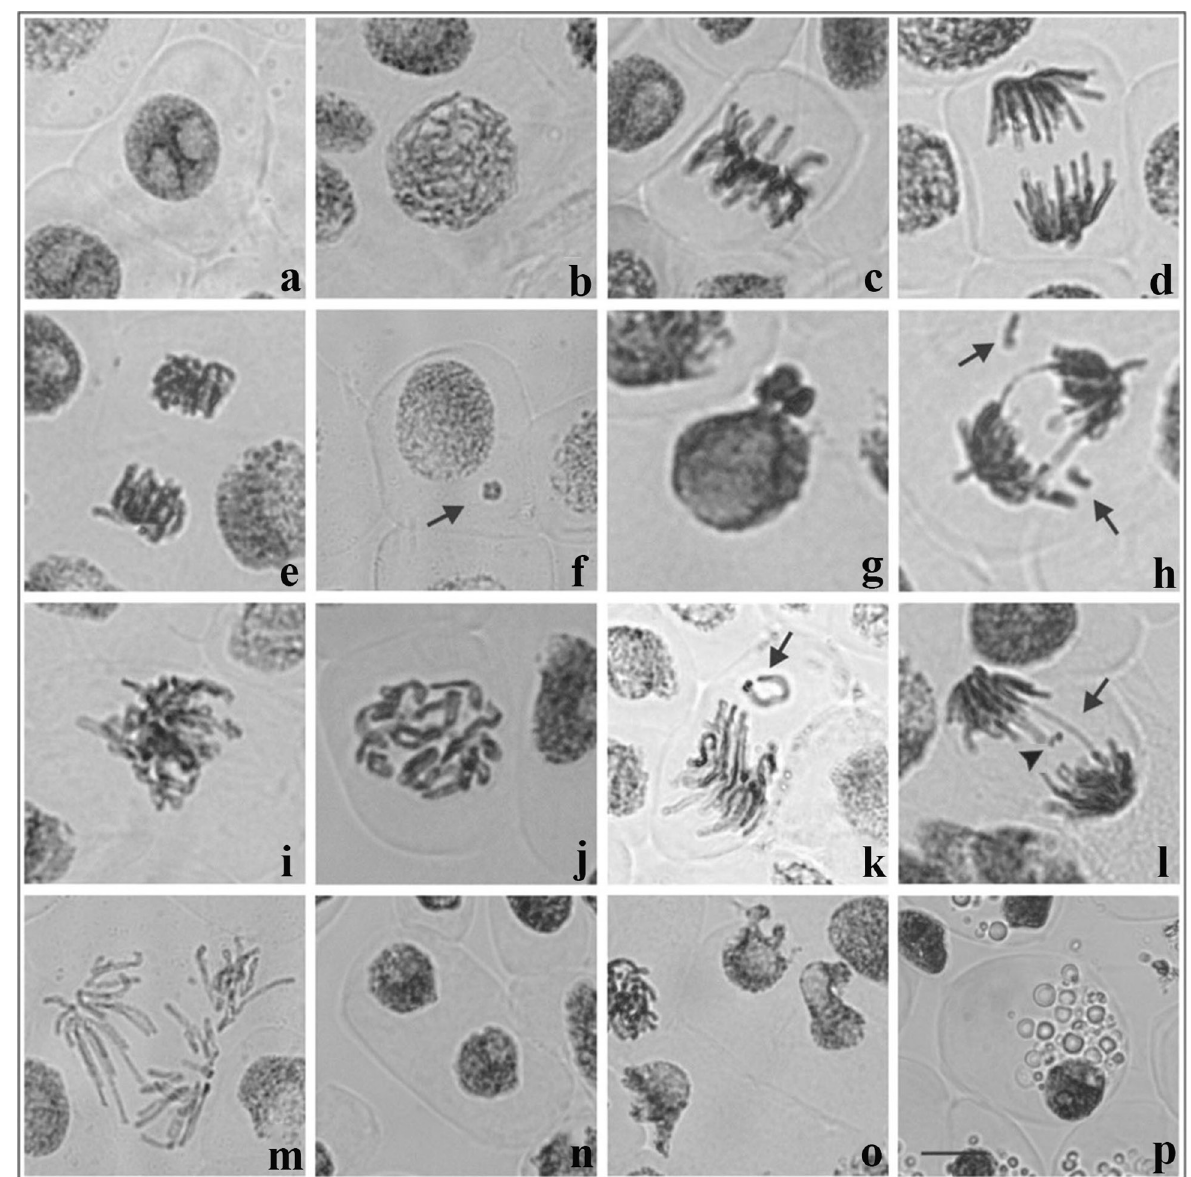
Figure 1. Chromosomal and nuclear alterations observed by the analysis of meristematic cells from Allium cepa roots. a) normal interphase. b) normal prophase. c) normal metaphase. d) normal anaphase. e) normal telophase. f) micronucleus (arrow). g) interphase with nuclear bud. h) chromosomal breaks (arrow). i) chromosomal adherence. j) C-metaphase. k) chromosomal loss (arrow). l) chromosomal bridge (arrow) and chromosomal break (arrow head). m) multipolar anaphase. n) binucleated cell. o) nuclear alteration. p) cells under death process (heteropicnotic nucleus displaced for cell periphery; vacuolization anda cytoplasm swelling). Bar: 10 µm (for all images). All chromosomal changes were observed for piperine and capsaicin, except multipolar anaphase for